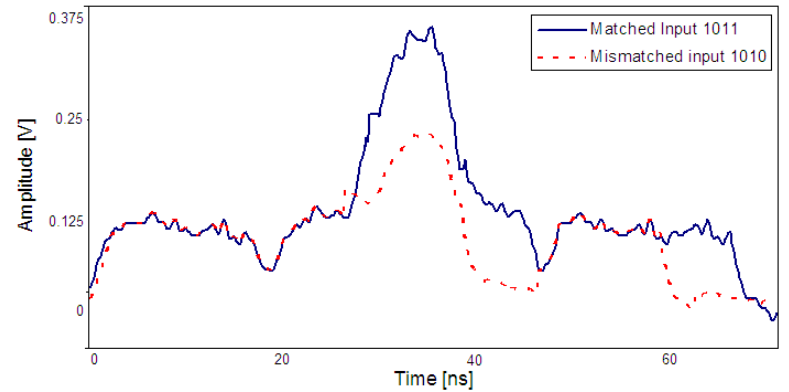
Figure 6 . Correlation output with matched input 1011 and worst-case mismatched input signal